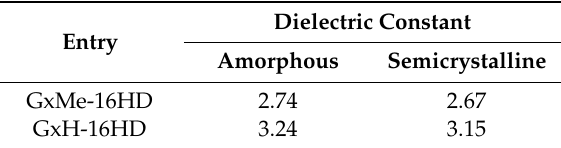
Table 3. Dielectric constant of GxMe-16HD and GxH-16HD determined with an additive molar group contribution (calculation for theoretically amorphous, respectively, 50% semicrystalline samples).